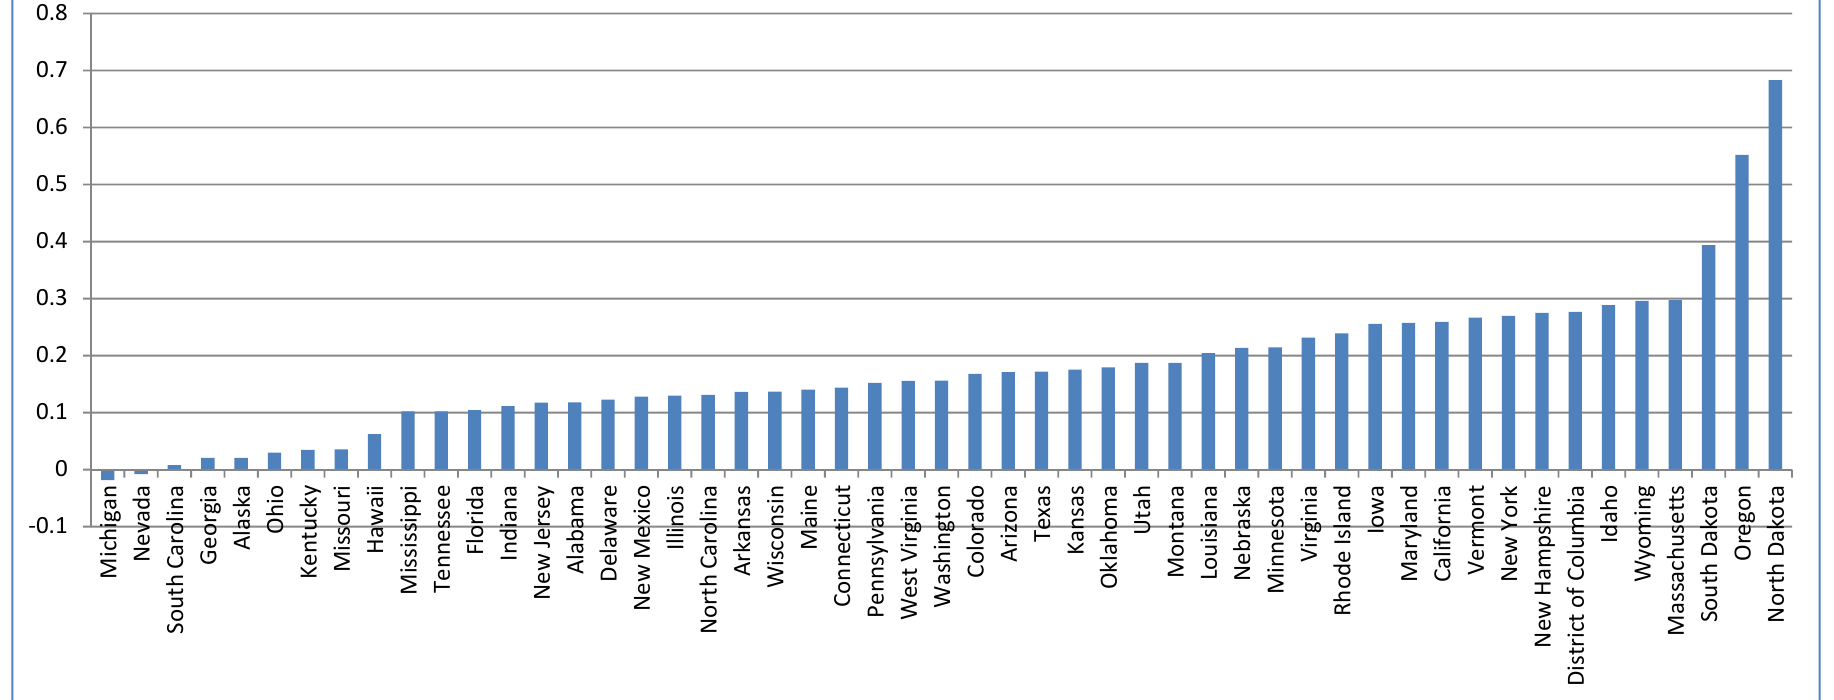
Figure 1. Per capita real GDP change, 1997–2011, by state (chained 2005 dollars).